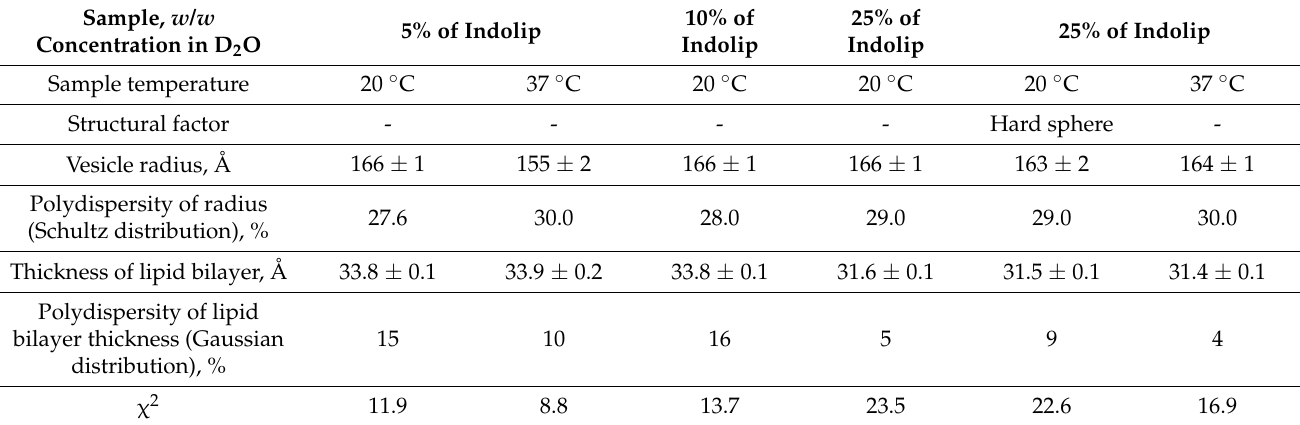
Table 3. Parameters of Indolip nanoparticles under various